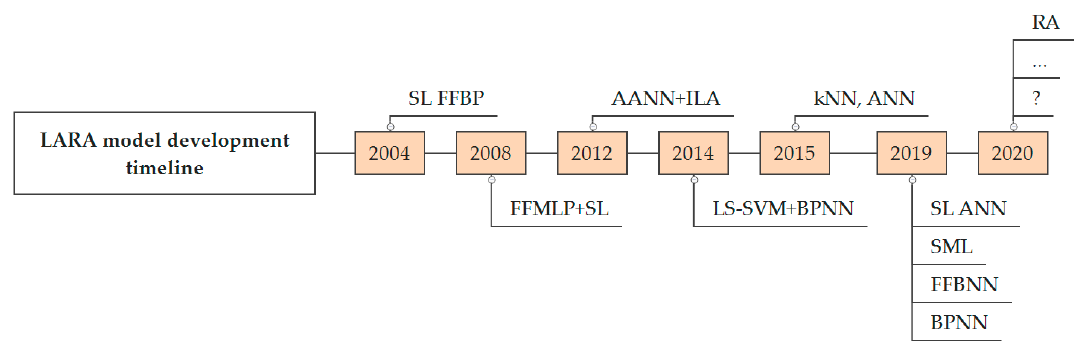
Figure 7. LARA model’s development